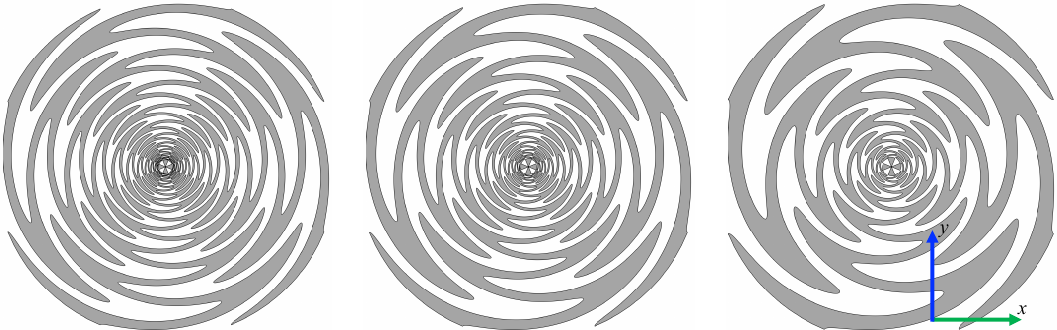
Figure 1. Sinuous antennas having parameters: P = 20 cells, τ = 0.8547 ( left ); P = 16 cells, τ = 0.8228 ( center ); and P = 12 cells, τ = 0.773 ( right ). Other parameters constant for all antennas: N = 4 arms, R T = 10 cm, R in = 0.4 cm, α = 45 ◦ , and δ = 22.5 ◦ .